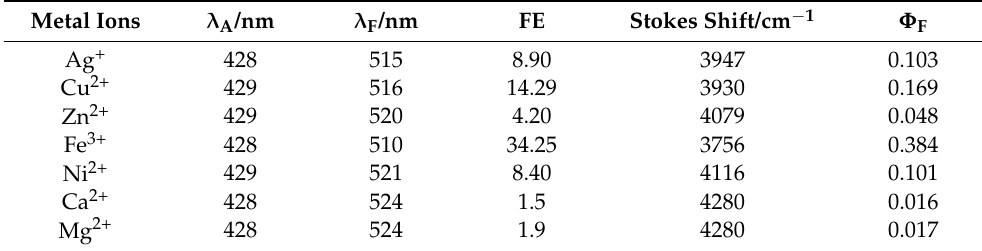
Table 4. Photophysical characteristics of NI2 in DMF solution and presence of metal